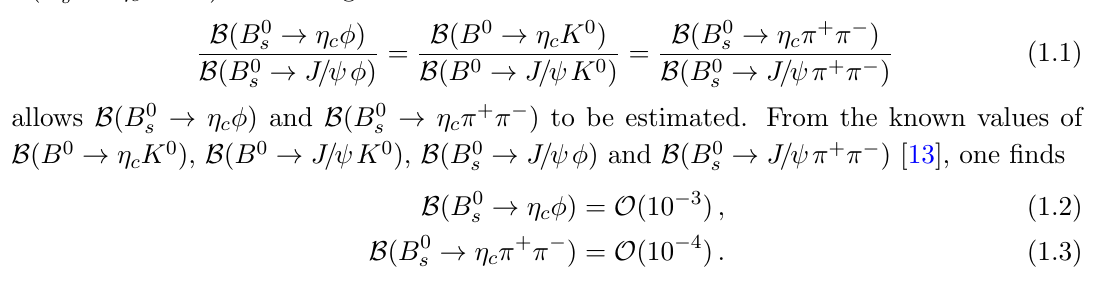
analyses of B 0 ! (cid:17) (cid:30) and B 0 ! (cid:17) (cid:25) + (cid:25) (cid:0) decays. Instead, the (cid:12)rst measurement of their c c s s branching fractions is performed. No prediction is available for either B ( B 0 B ( B 0 ! (cid:17) (cid:25) + (cid:25) (cid:0) ). c s